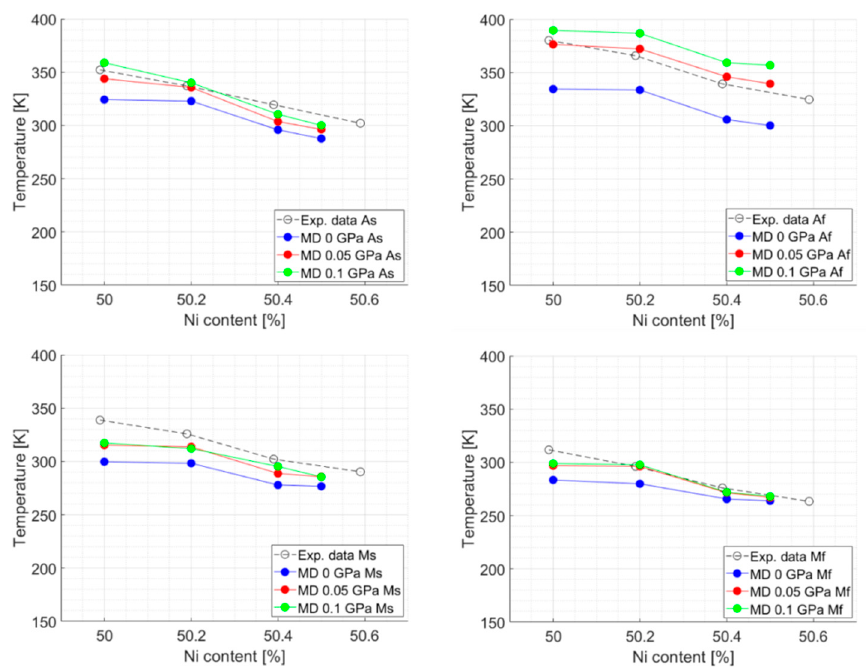
Figure 8. Phase transformation temperatures of Ni-rich NiTi with different Ni contents. Experimental data were adapted from Ref. [16].